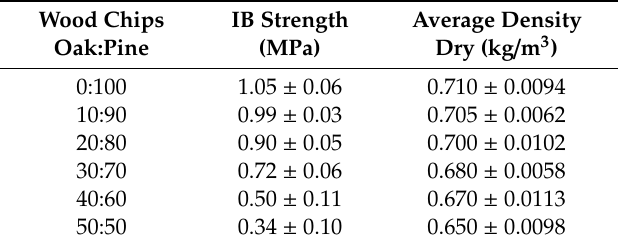
Internal bond (IB) strength of laboratory particleboard panels prepared using a melamine-urea-formaldehyde (MUF) resin on mixed wood furnish oak: pine at di ff erent ratios. Wood Chips IB Strength Average Oak:Pine (MPa)